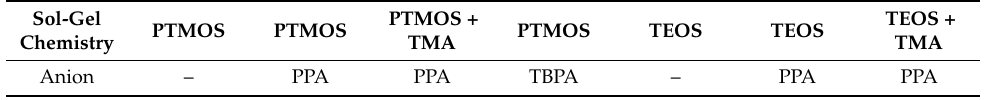
Table 6. Various formulations of sol ‐ gel coatings.